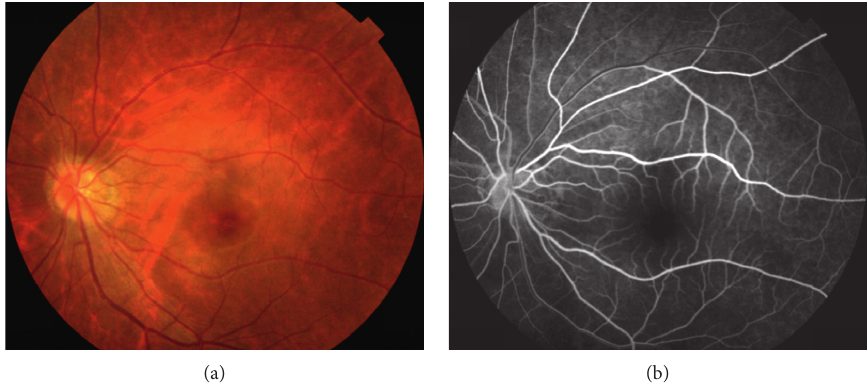
Figure 4: Fundus photograph and fluorescein angiogram at 4weeks demonstrated returning to